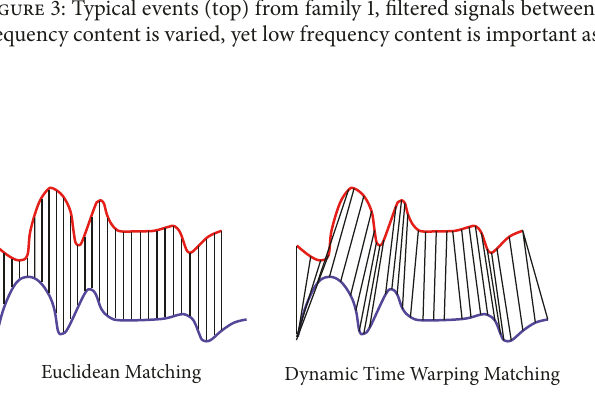
Figure 4: Comparison of signal matching done in Euclidian and DTW fashion (modified from